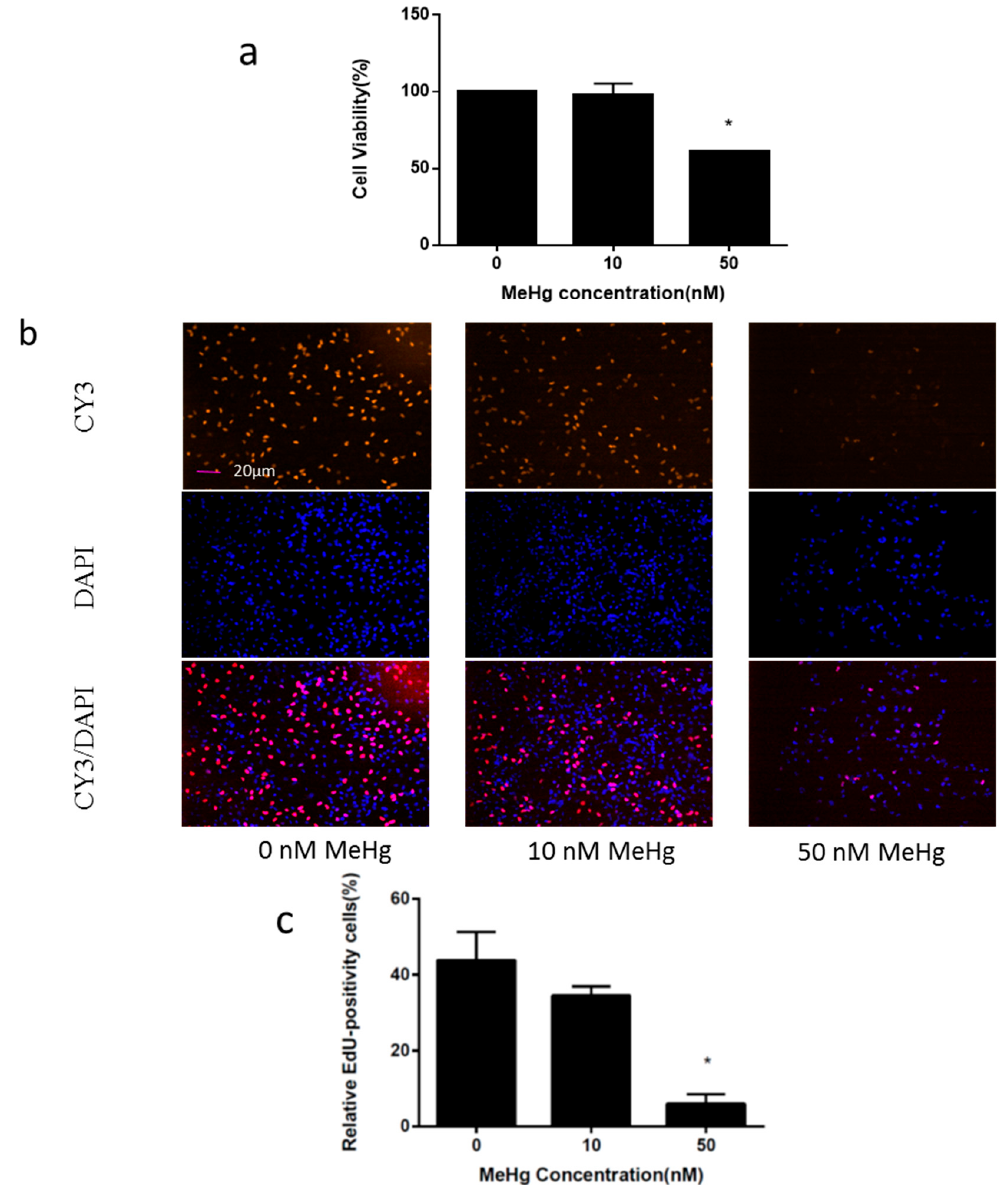
Figure 1. Immortalized human neural progenitor cells (ihNPCs) were highly susceptible to methylmercury (MeHg)-induced toxicity. ( a ) Altered cell viability induced by MeHg treatment; ( b ) 5-Ethynyl-2 ′ -deoxyuridine (EdU)-positive cells induced by MeHg treatment. Fluorescent image of EdU incorporation and staining in ihNPCs after MeHg treatment. Blue: 4 ′ ,6-diamidino-2-phenylindole (DAPI); Red: cyanine (CY) 3. Scale bar: 20 µm; ( c ) Quantification of Edu-positive cells. Results were expressed as mean ± SEM ( n = 3). * p < 0.05 when compared with the corresponding control group (0 nM MeHg).